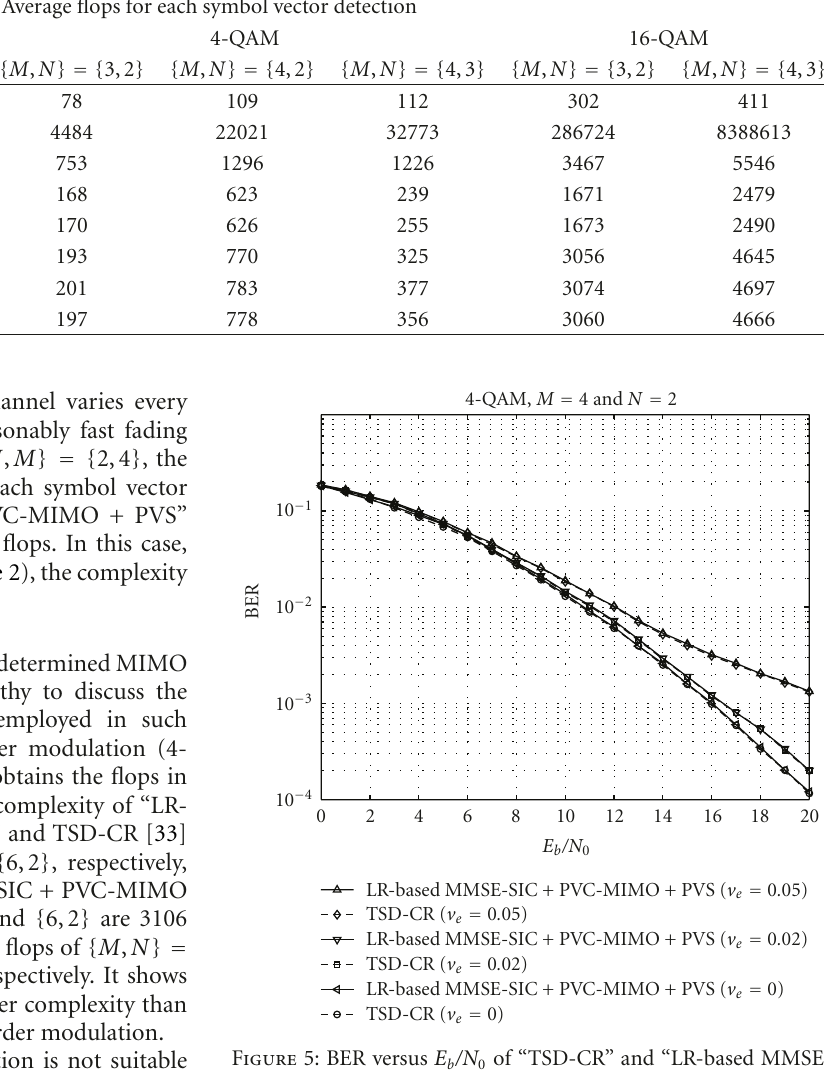
with di ff erent CSI errors, where v e = 0, 0.02, and